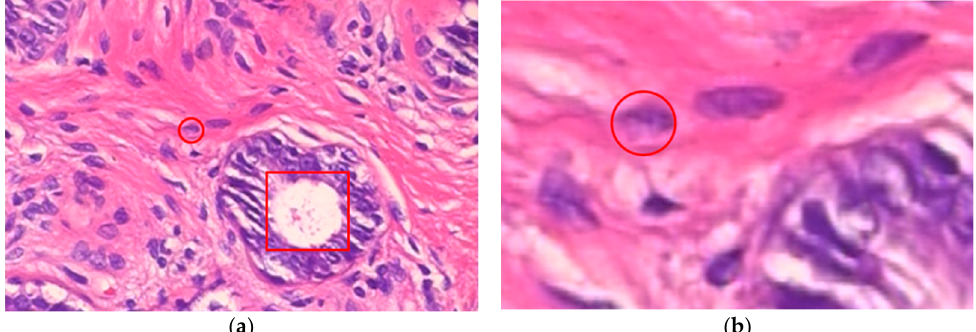
Figure 4. ( a ) show histopathological images at coarse-scale; ( b ) show histopathological images at finer scale.